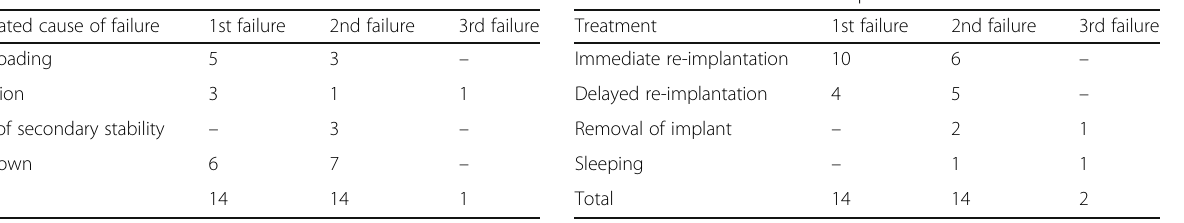
Table 3 Treatment of failed